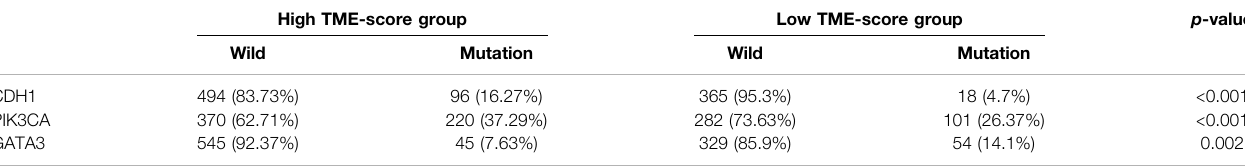
TABLE 2 | Signi fi cantly mutated genes between high and low TME score